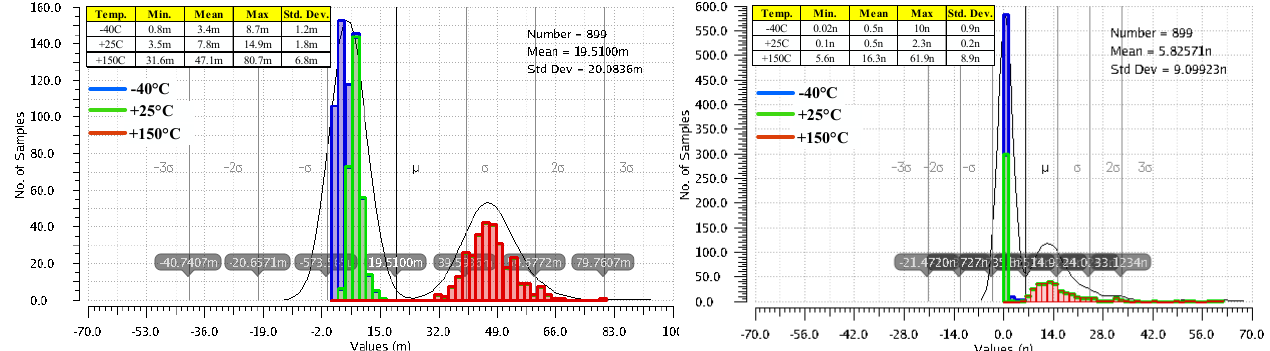
Figure 10. Variation of the LDO output voltage when VIN changes its value from 1.25 V to 1.5 V, while the load current is kept constant, IL = 1 mA. Results yielded by 300 Monte Carlo simulation runs for three temperatures, − 40 °C, +25 °C, and +150 °C.